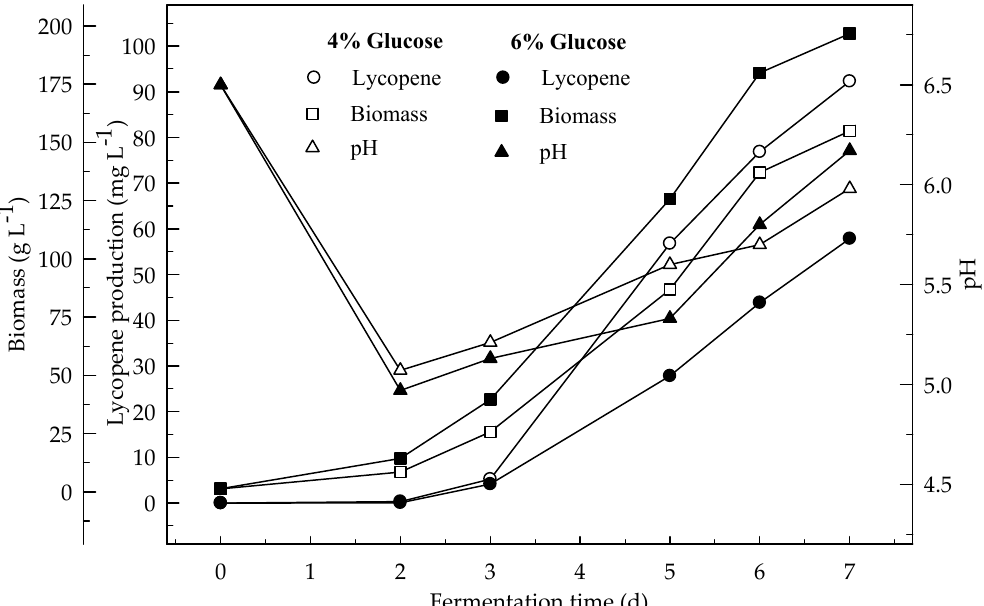
Figure 7. Changes in lycopene production, biomass formation and pH in a fermentor with an initial pH 6.5 in a 4 and 6% glucose medium at 12 L min − 1 aeration and 750 rpm agitation.